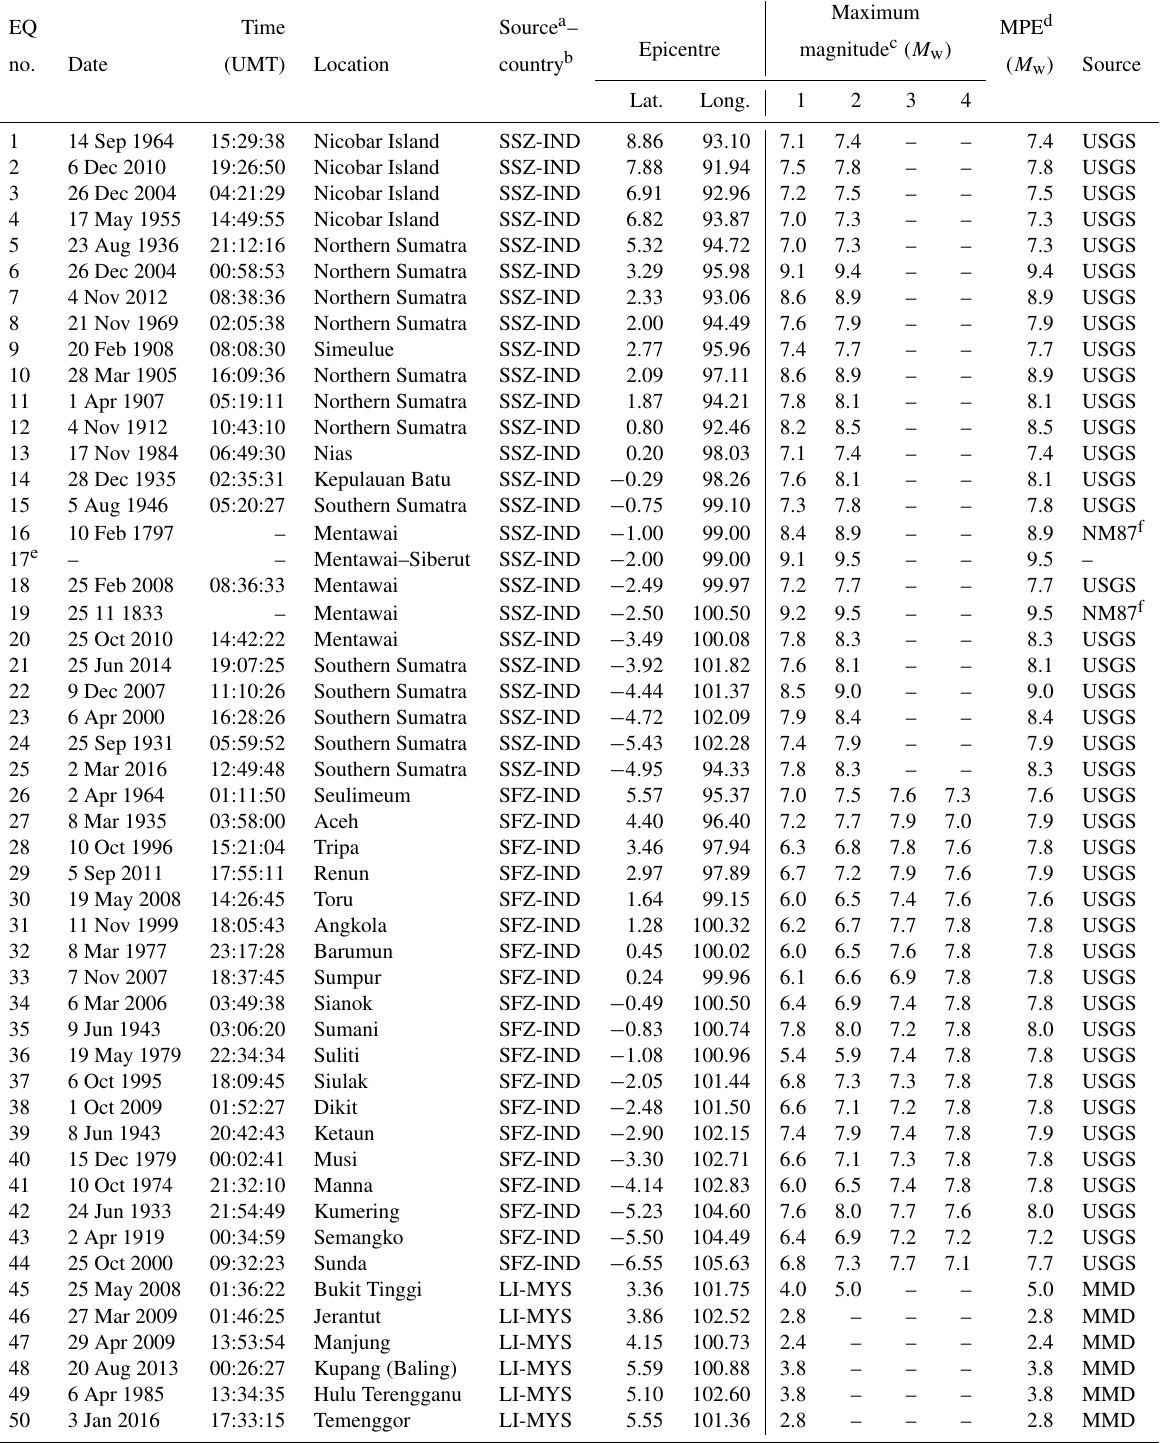
Table 2. List of MPEs from all three sources used in the DSHA. EQ Time Source a – MPE d